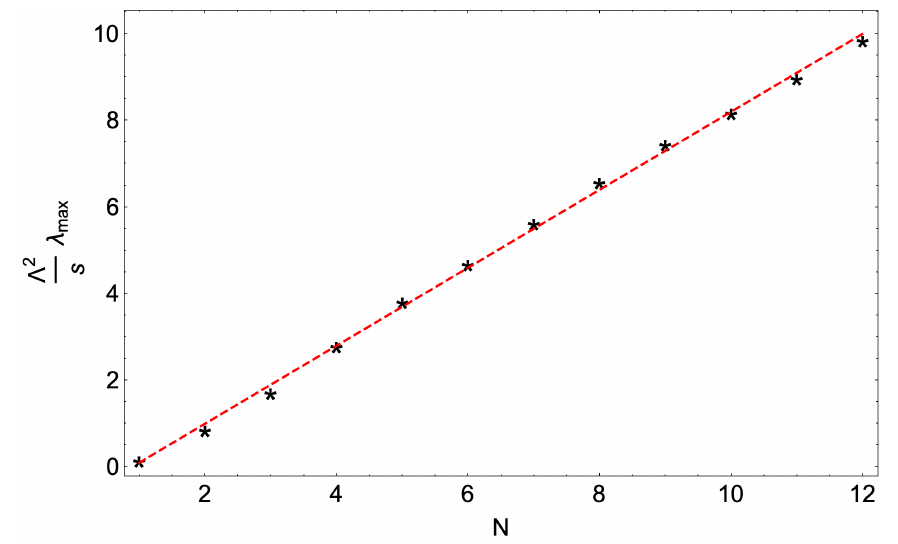
Figure 9 . Largest eigenvalue of the graviton scattering matrix λ max rescaled by Λ 2 /s as a function of N . The red-dashed line shows the linear fit that was used to extract the perturbativity